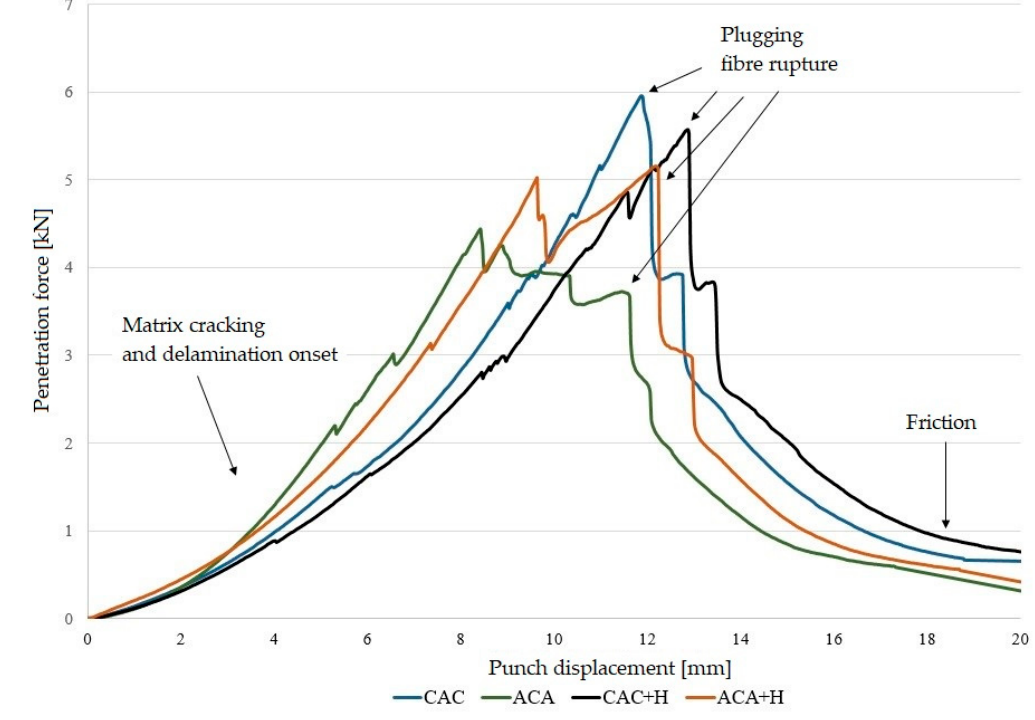
Figure 7. Variation of penetration force curves for hybrid laminates.